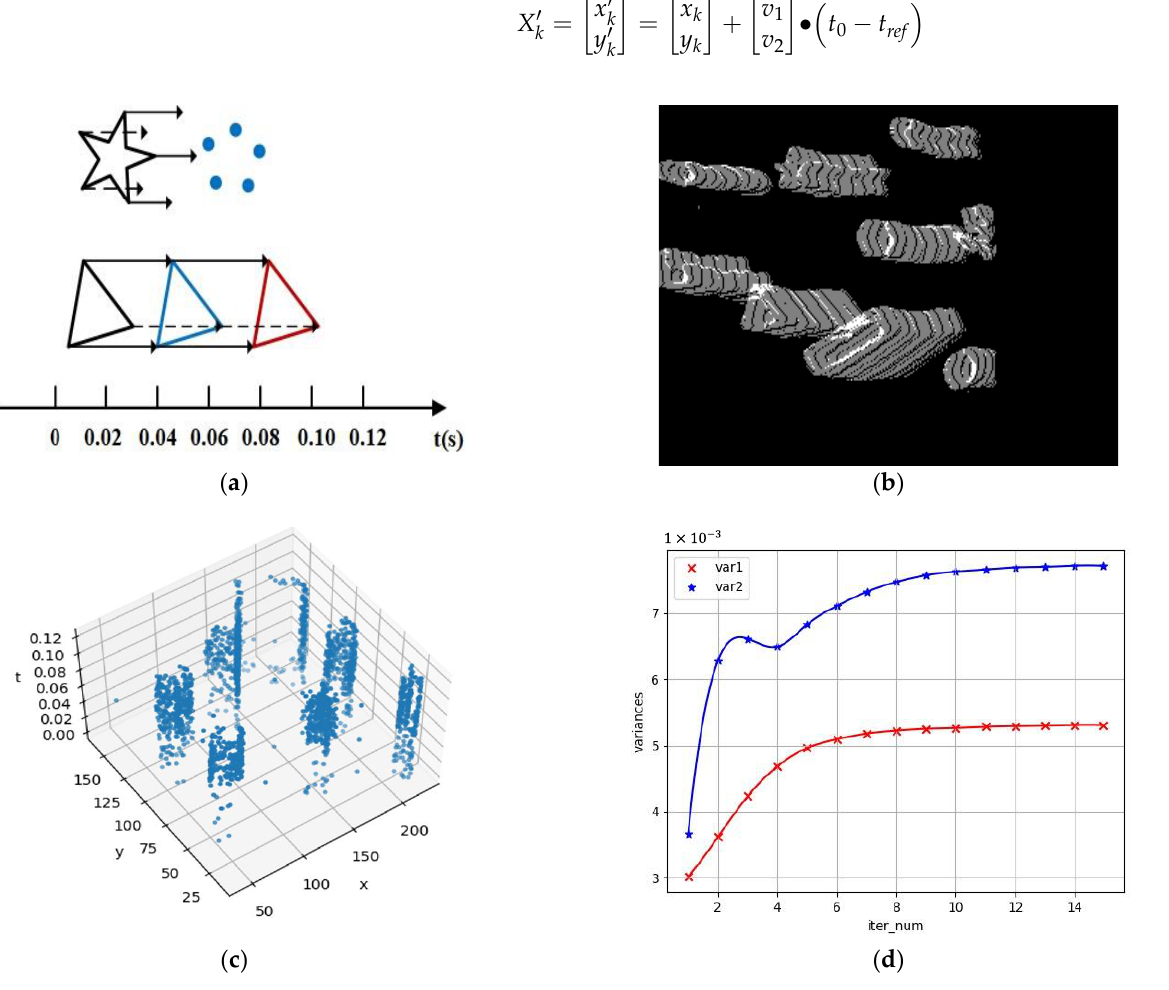
Figure 3. Updating the tracking template. Figure ( a ) is the update process of feature points and template points in a fixed time interval, while Figure ( b ) is an optical flow visualization of the tracking template. As shown in Figure ( c ), the events obtain the optical flow in the first spatio- temporal window. Figure ( d ) presents variance convergence curves. Variance 1 and Variance 2 represent the variance change in IWE after events are warped along with different optical flows.